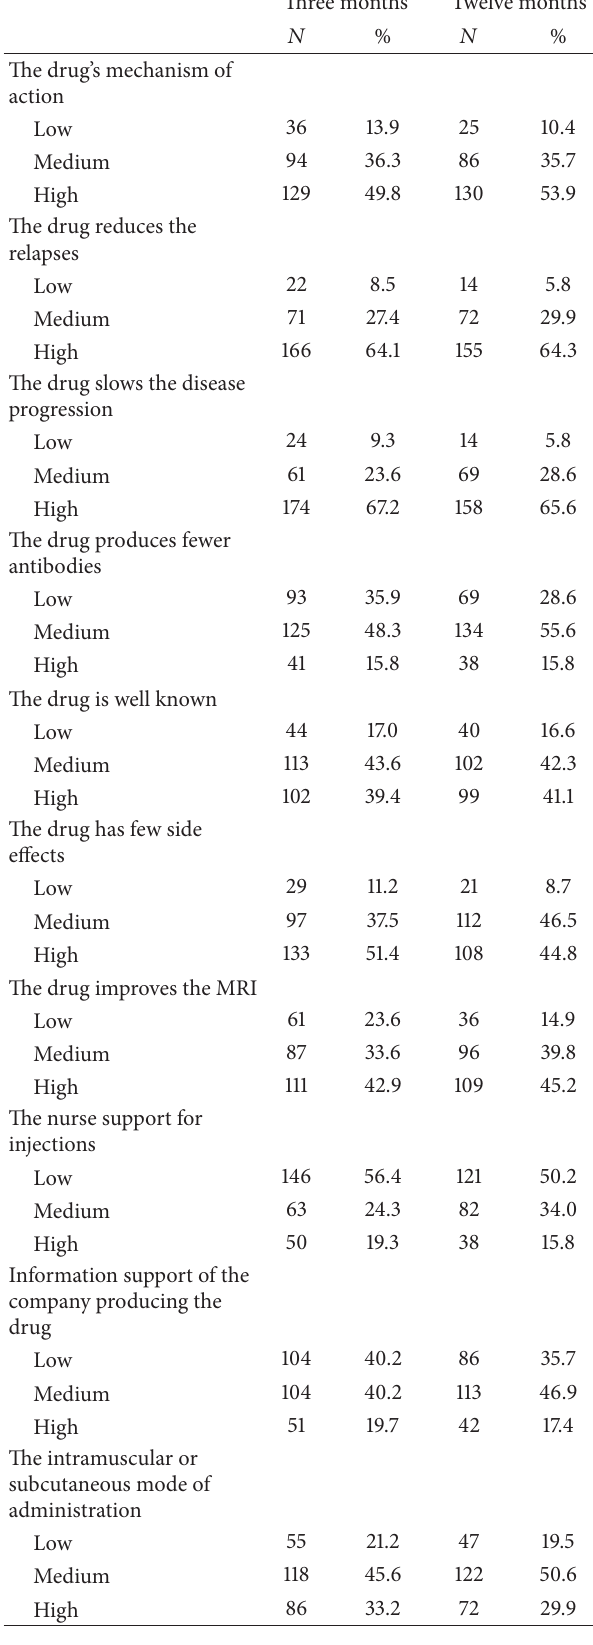
Table 3: “What is your main resource in coping with the illness?”